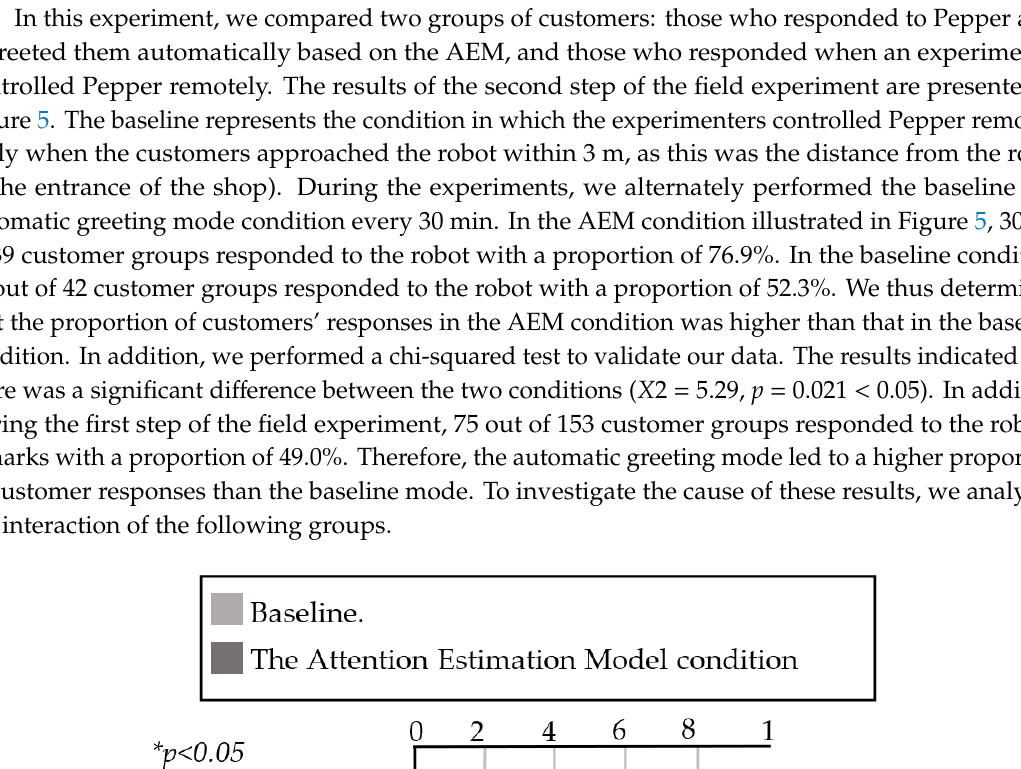
Table 2. Conversation in baseline condition (20 September